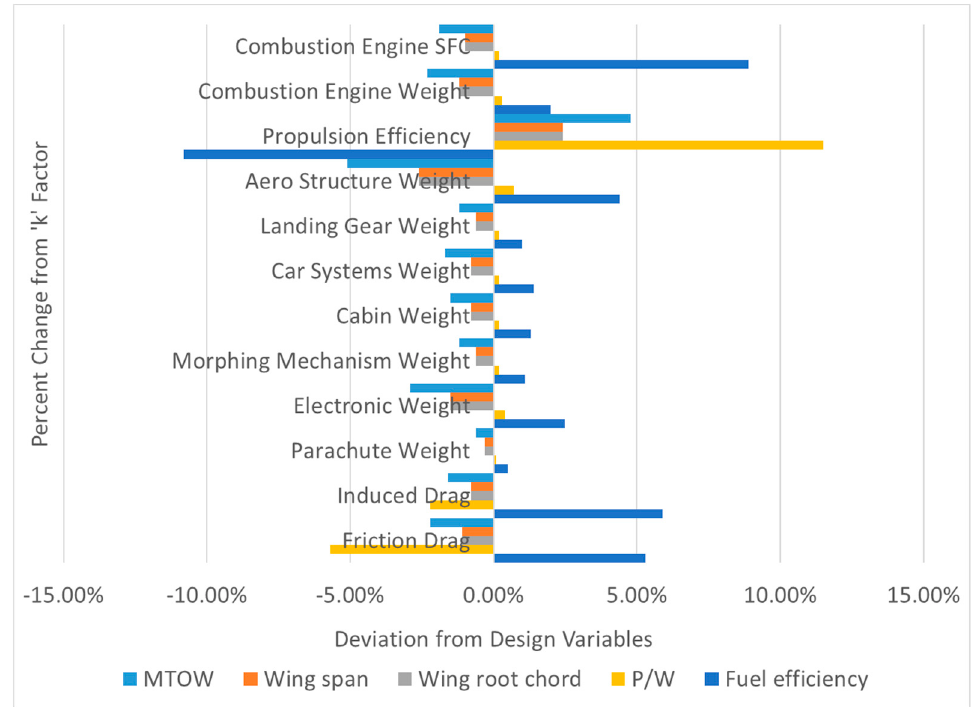
Figure 14. K-factor sensitivity analysis: deviation of design variables 1 for 10% decrease of the k factor.